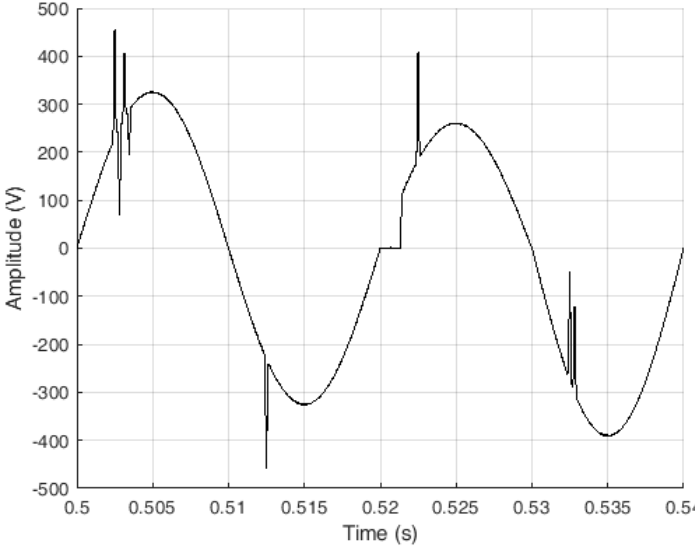
Figure 10. Test signal with interruption, swell, dip and transients.